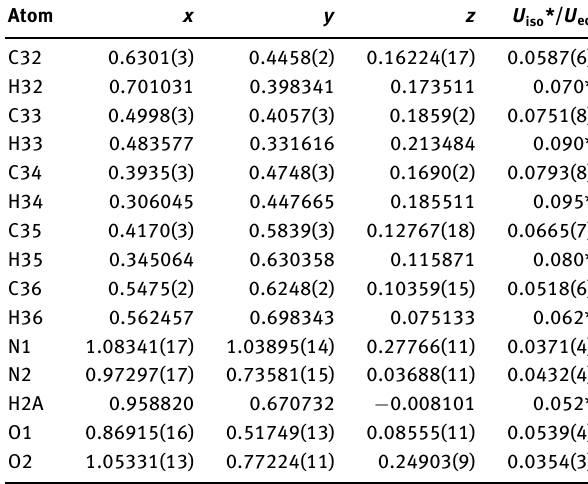
Table 2: Fractional atomic coordinates and isotropic or equivalent isotropic displacement parameters (Å 2